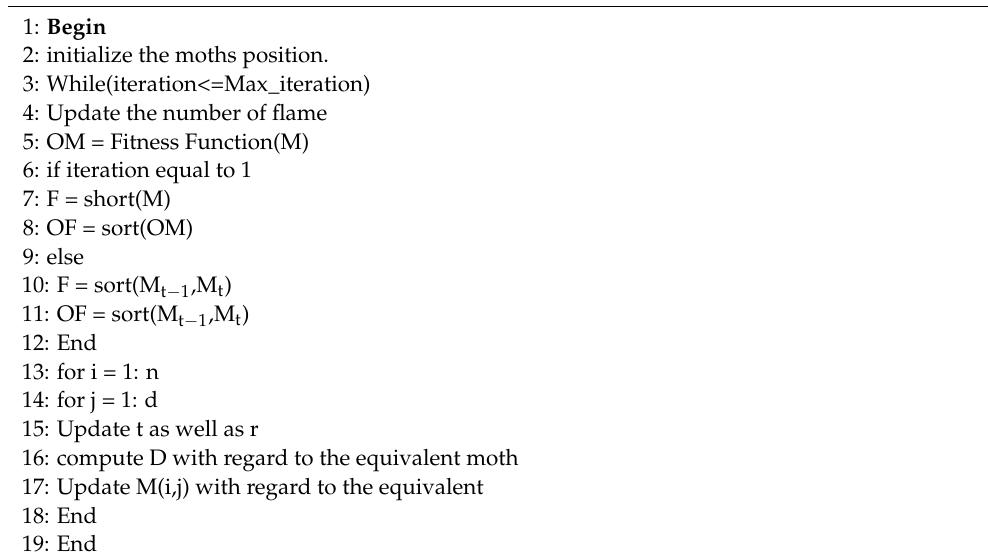
Algorithm 1 (MFO) The pseudocode of the moth–flame